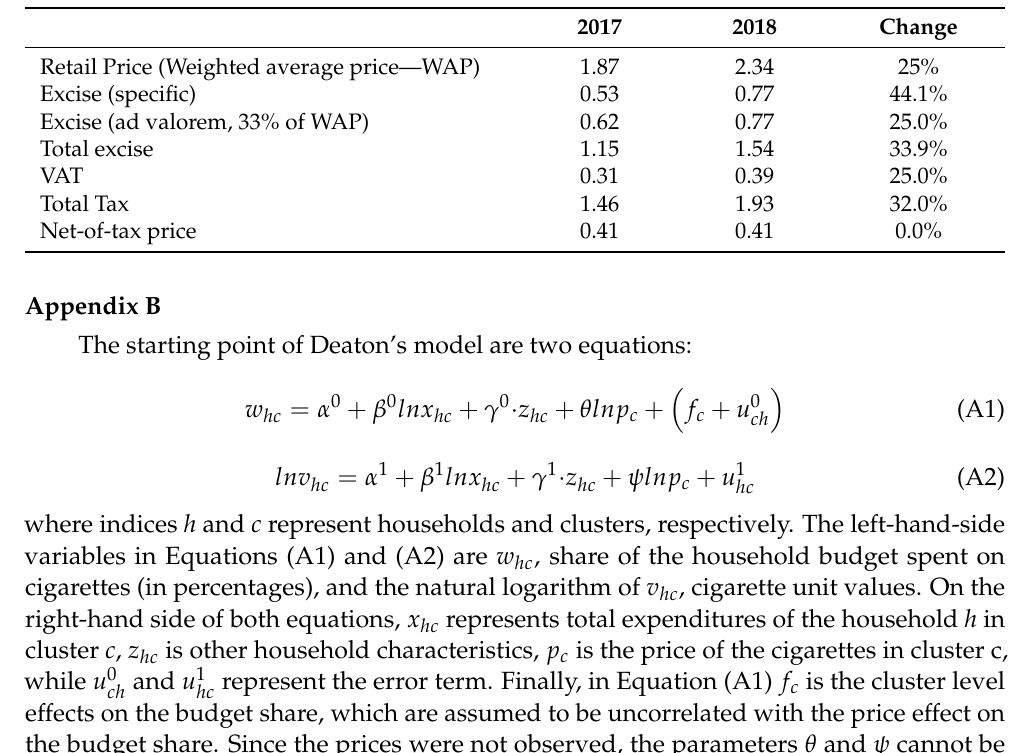
Table A7. Calculation of new price for 2018 by price